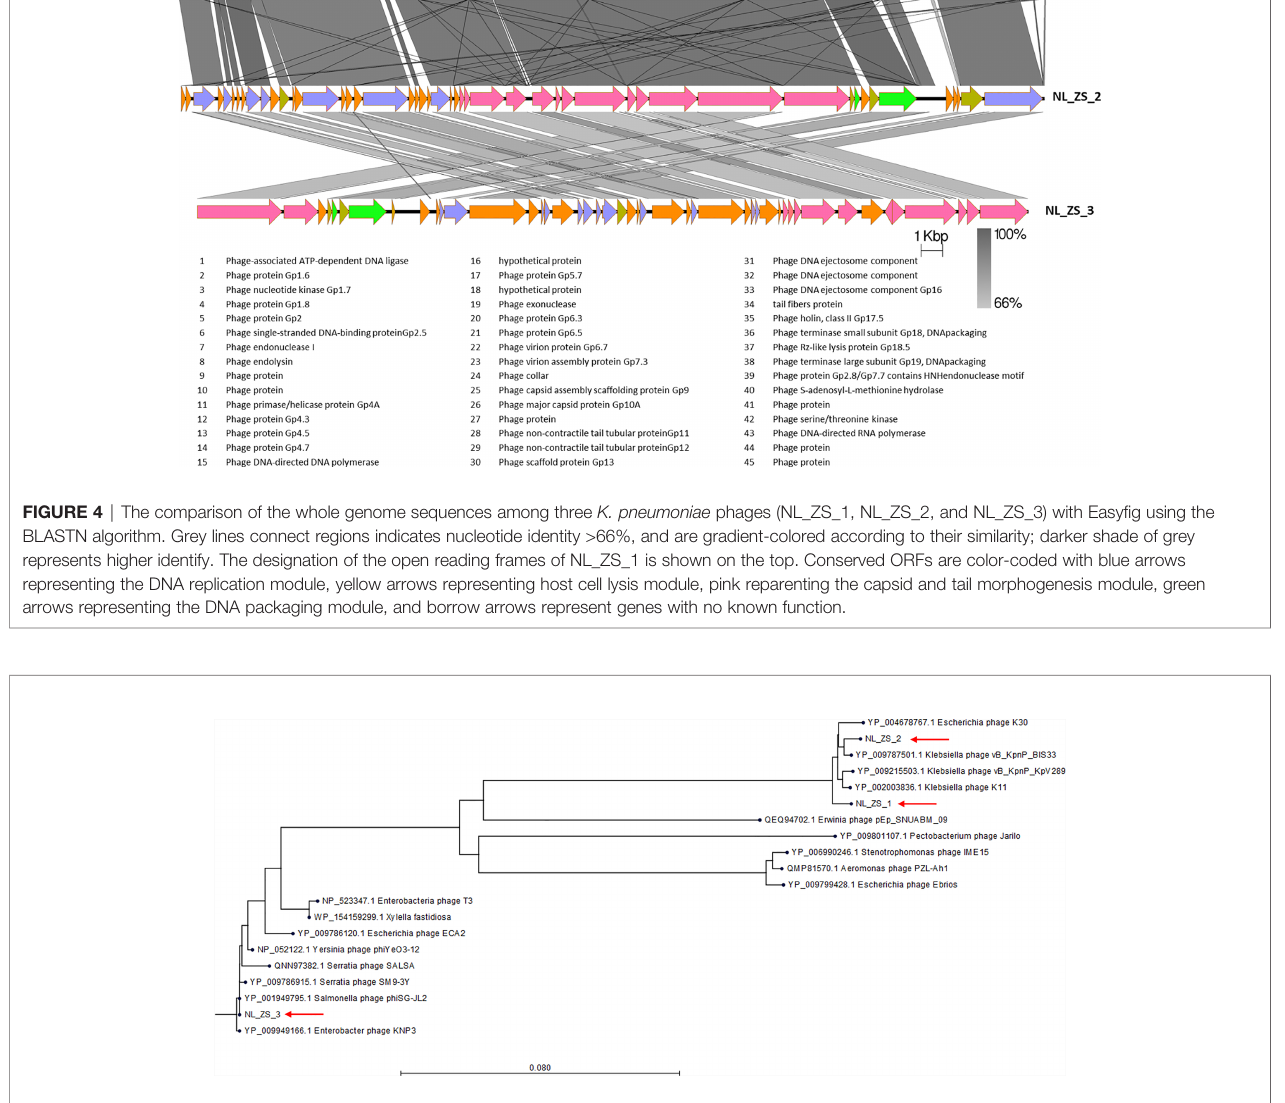
FIGURE 5 | Phylogenetic tree was constructed based on the amino acid sequence of the larger terminase subunit of phages NL_ZS_1, NL_ZS_2, and NL_ZS_3 and phages sharing homology sequence identity retrieved from GenBank (https://www.ncbi.nlm.nih.gov/). The evolutionary history of 20 larger terminase subunit amino acid sequences were aligned and inferred using Neighbor Joining method and 1000 bootstrap replicates (CLC Genomics Workbench